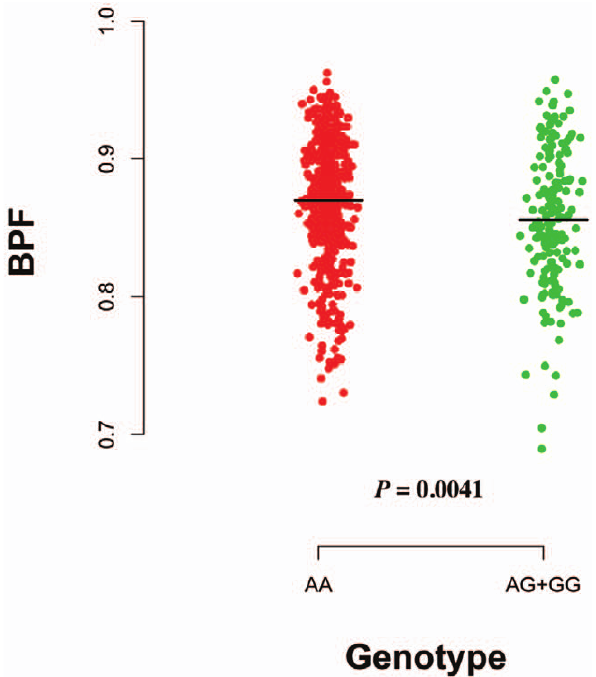
the best fit for the effect of PCK1 (rs8192708 G ) on the baseline brain volume as measured by brain parenchymal fraction (BPF). We compare the homozygotes for the non-risk allele (AA) to the combined heterozygotes (AG) and homozygotes (GG) for the risk allele. The minor allele (G) frequency is 0.14.